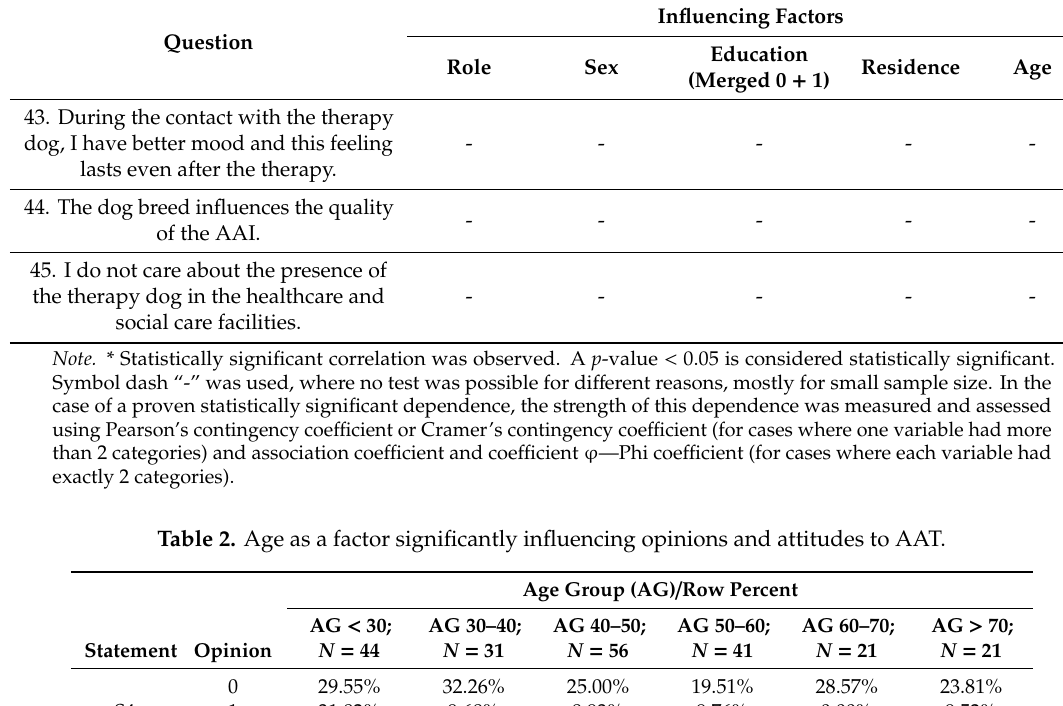
Table 1. Cont. Role Sex